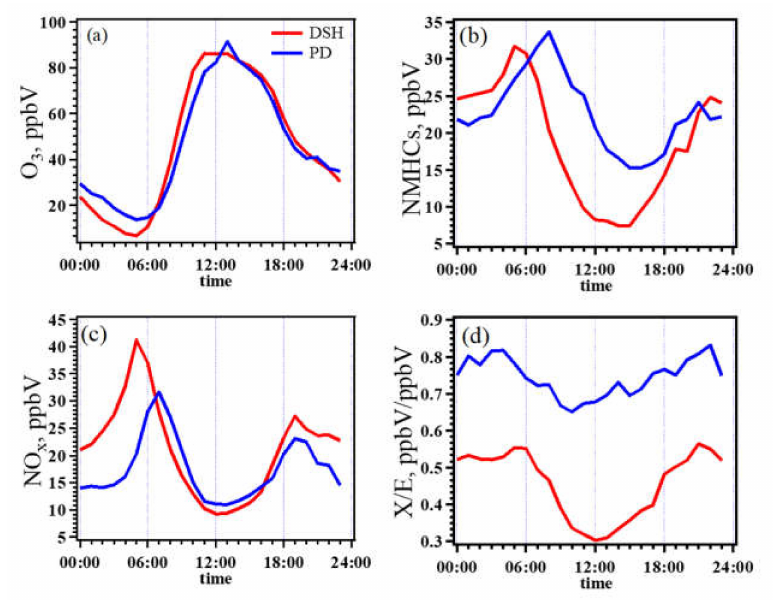
Figure 3. Mean diurnal variations of the measured ambient levels for ( a ) O 3 , ( b ) non-methane hydrocarbons (NMHCs), ( c ) NOx, and ( d ) ratios of o -xylene to ethylbenzene (X / E) at the DSH site (red line) and PD site (blue line) from 1–31 July